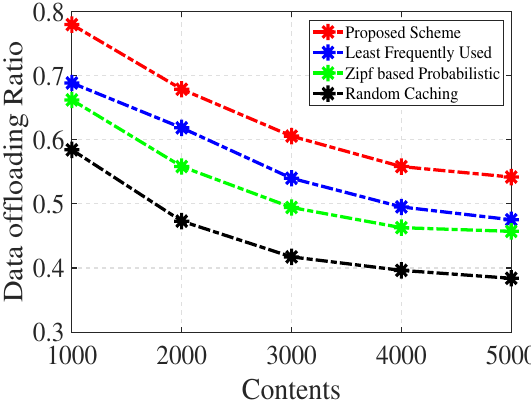
Figure 5. Data offloading ratio versus contents with U = 50, H = 50 MB, and Q = 1 GB.